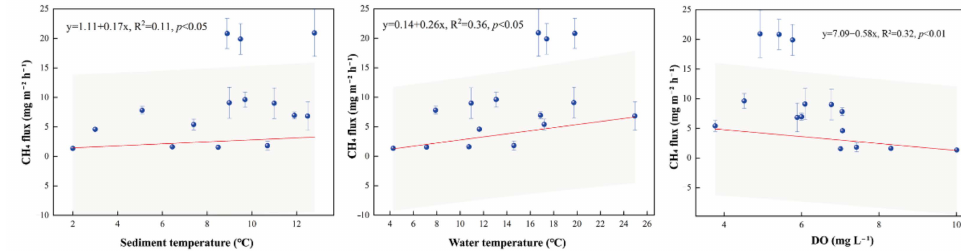
Figure 3. Correlation of total CH 4 fluxes in the pelagic zone with sediment temperature, water temperature, and dissolved oxygen (DO). Shaded areas indicate 95% confidence intervals.